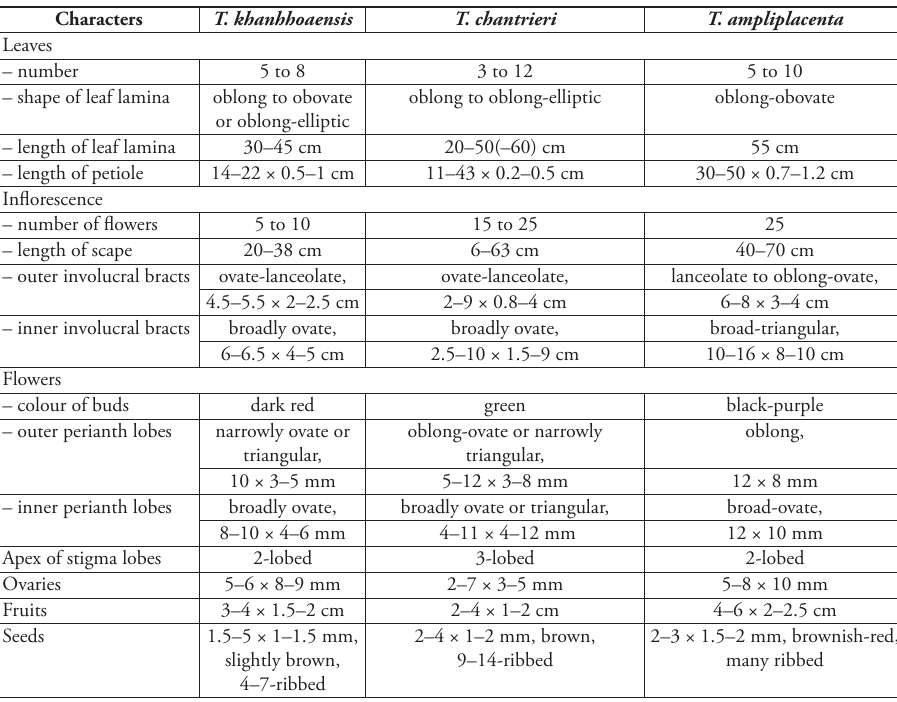
Table 1. Morphological comparison of Tacca khanhhoaensis with its closest congeners (modified from Drenth 1972 ; Phengklai 1993 ; Ding and Larsen 2000; Pham 2000 ; Zhang et al. 2008; Baruah et al. 2015